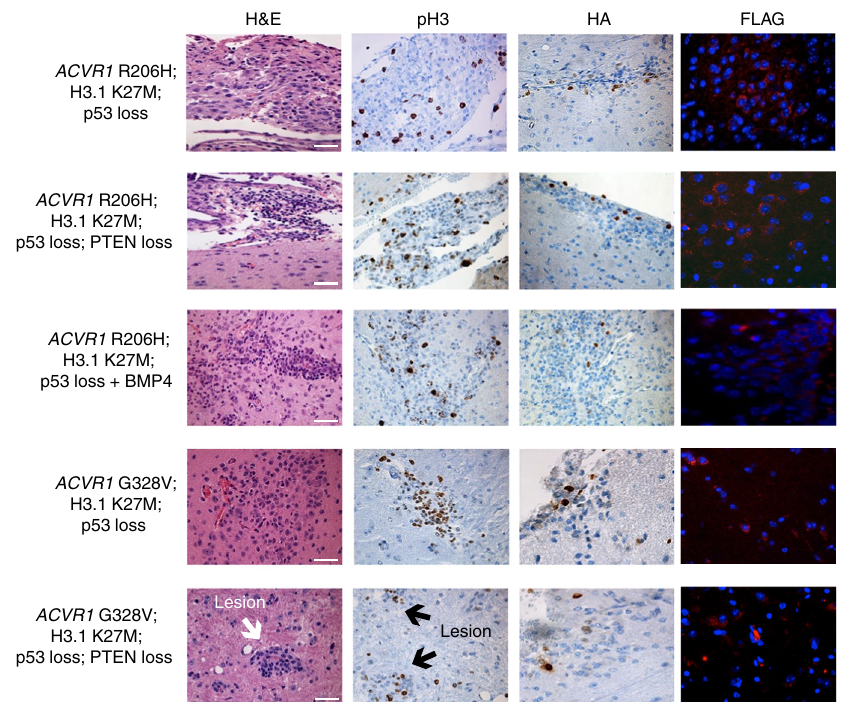
Fig. 2 ACVR1 mutants with H3.1K27M and p53 loss form glioma-like lesions. Representative H&E, IHC, and IF images for proliferation